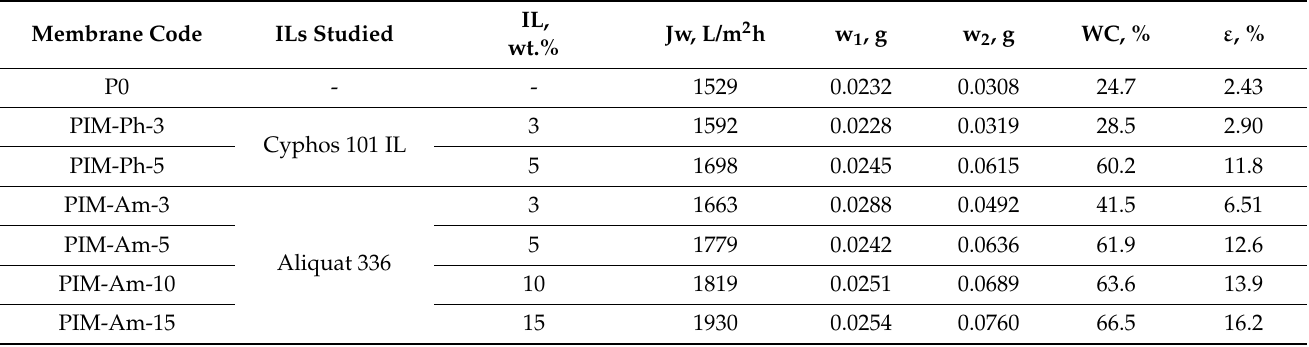
Table 1. Characteristics of the membranes studied.